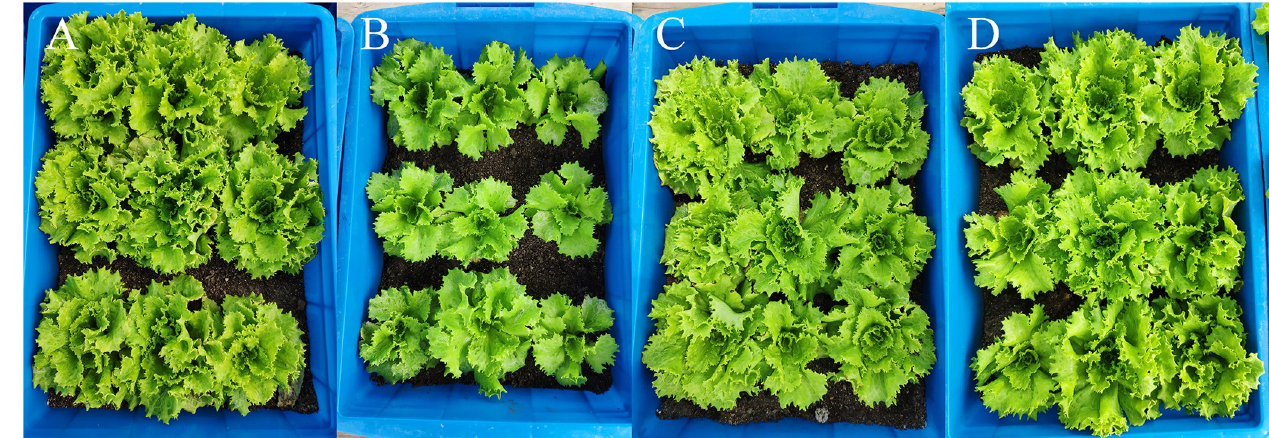
Fig 6. Photographs of the morphological differences of the four treatments on the 58 th day after sowing. T 1 (A), T 2 (B), T 3 (C), T 4 (D).